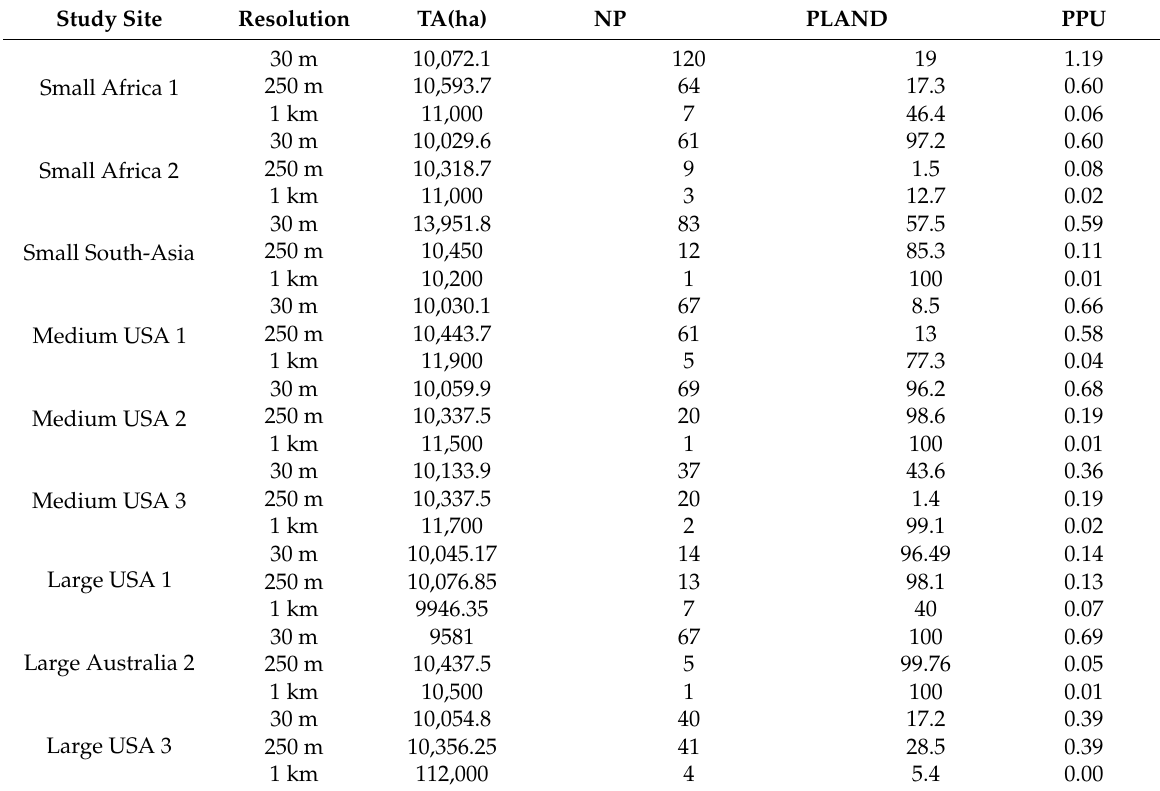
Table 16. Landscape parameters in different resolution maps for all study